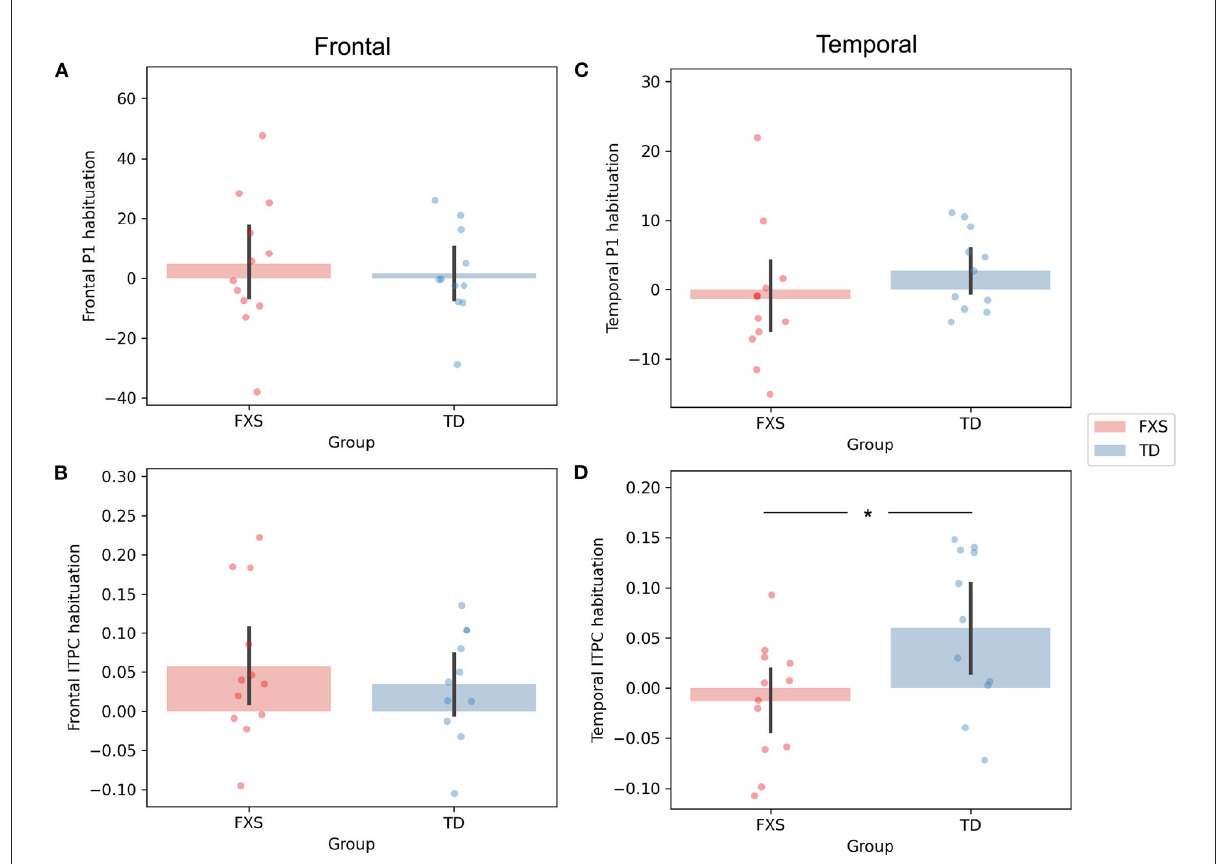
FIGURE5 Comparison of habituation (ST1 – ST5) of (A) frontal P1, (B) frontal ITPC, (C) temporal P1, and (D) temporal ITPC between conditions and groups. * p <